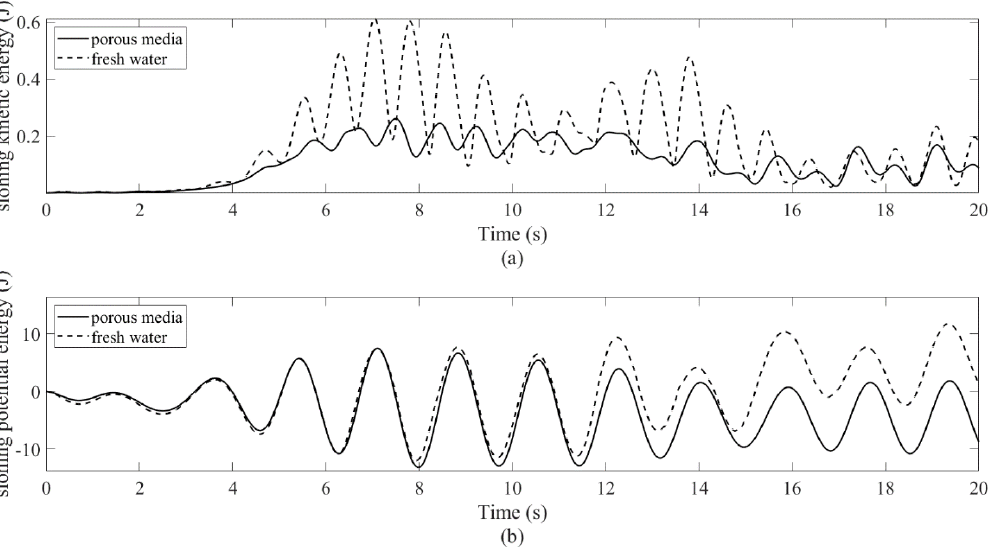
Figure 31. The energy changes of the sloshing fluid in the water tank: ( a ) kinetic energy; ( b ) potential energy. The free-surface elevations on the left-side wall of the tank with and without porous media are shown in Figure 32. The wave elevation in the tank without porous media was very nonlinear, while the porous media reduced the degree of nonlinearity due to their extra damping effect. This shows the benefit for the liquid storage tank that not only the dynamic pressure can be reduced, but the roof damage can be alleviated. Figure 32. The wave elevations on the left-side wall of the tank with and without porous media. The wave elevations of four gauges distributed at x = 2, 4, 6, and 8 m (two on the left side and two on the right side of the body) along the channel are shown in Figure 33. At the beginning ( t < 2 s), the incident wave had not reached the body, so the body only oscillated vertically. The uncontrolled body had a larger initial acceleration, so it induced a larger disturbance to the waves, as shown in Figure 33b,c. The heave-induced wave that propagated downstream was recorded as is shown in Figure 33d. However, there was no